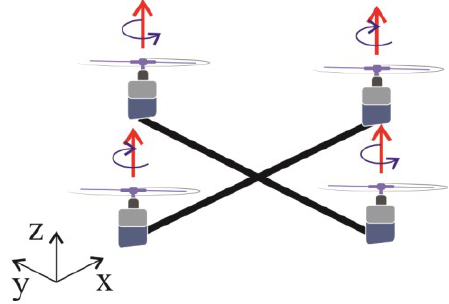
Fig. 2. Overview diagram of the examined